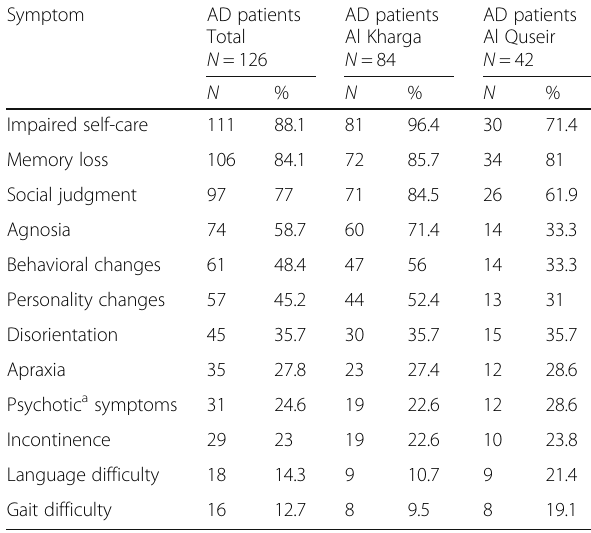
Table 5 Neuropsychiatric profiles of patients with Alzheimer ’ s disease in upper Egypt, Desert areas (AL Kharga and AL